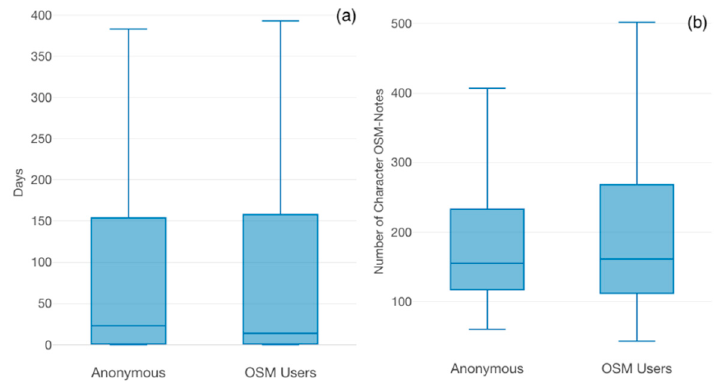
Figure 11. Comparison of anonymous and OSM users’ closed OSM Notes ( a ) number of days required for resolution and ( b ) number of characters.